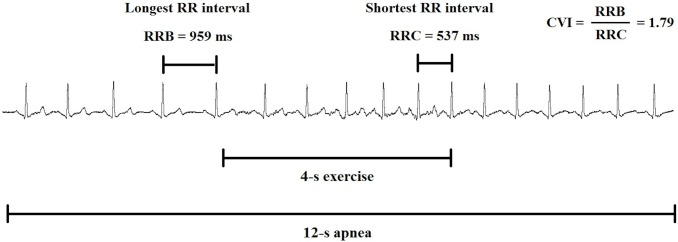
A typical ECG tracing during the 4-s exercise test in one subject of the sample.CVI: cardiac vagal index.